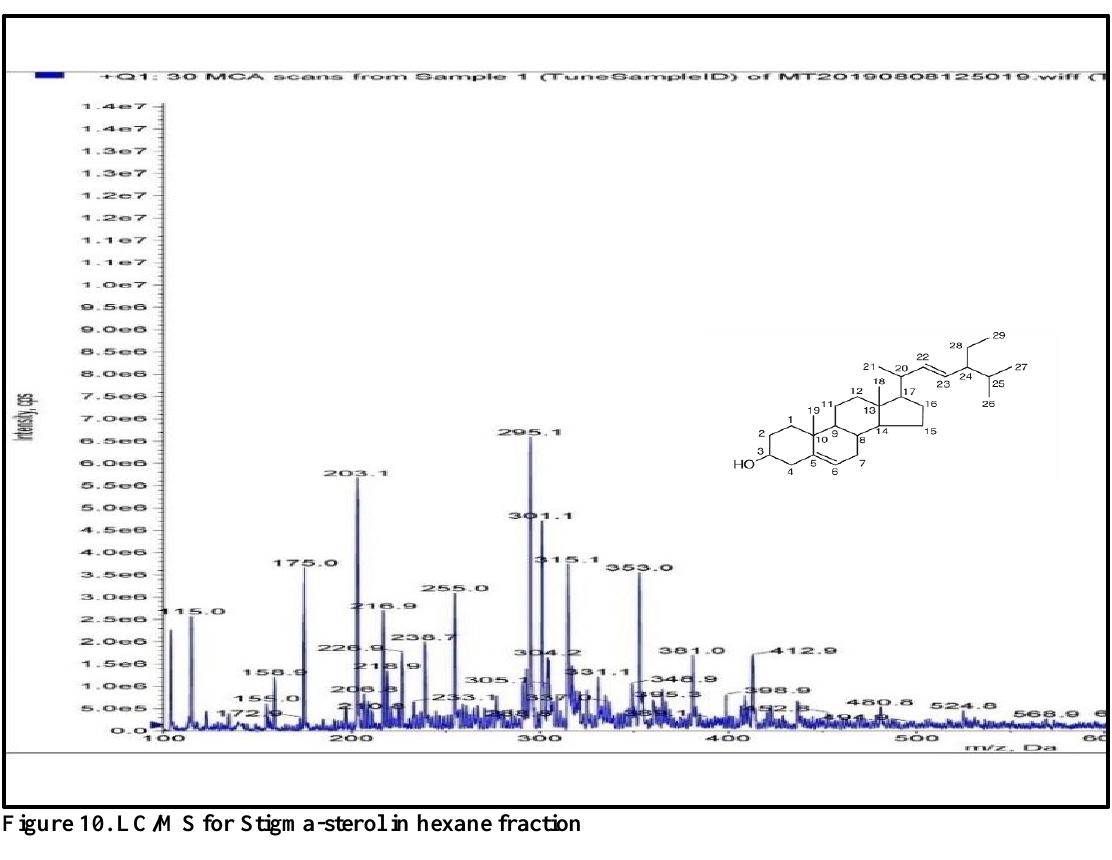
Figure 10. LC/MS for Stigma-sterol in hexane fraction Fragmentation pattern was complained with that reported in the literature for stigmasterol from an